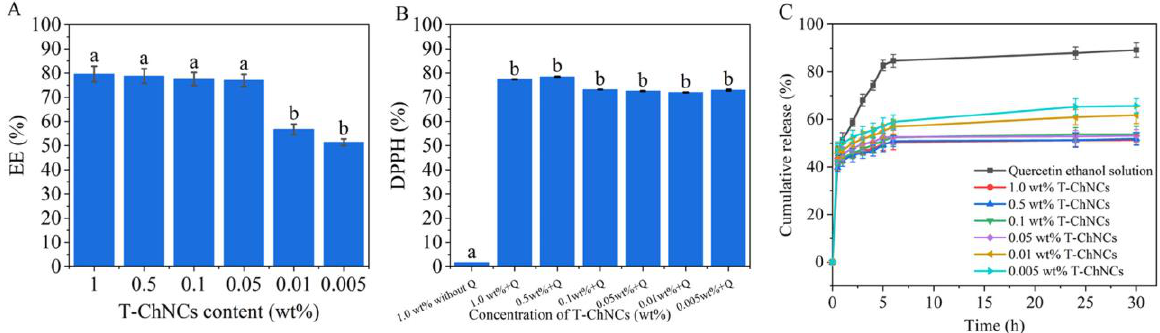
Figure 6. A . EE of TEMPO-oxidized ChNCs (T-ChNCs); B . Antioxidant activities of Pickering emul- Figure 6. ( A ) EE of TEMPO-oxidized ChNCs (T-ChNCs); ( B ) Antioxidant activities of Pickering sion stabilized by T-ChNCs with different concentrations; C . Release profiles of quercetin from Pick- emulsion stabilized by T-ChNCs with different concentrations; ( C ) Release profiles of quercetin ering emulsion stabilized by T-ChNCs with different concentrations. from Pickering emulsion stabilized by T-ChNCs with different concentrations. Different letters (a, b) represent significant differences ( p < 0.05).